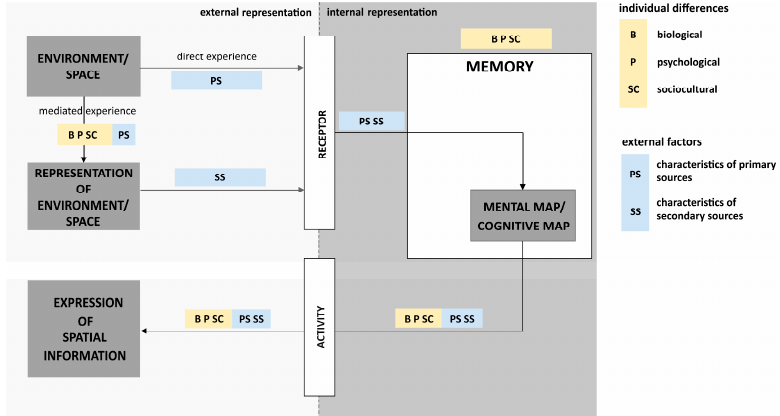
Figure 1. The process of spatial perception with a group of factors (Source: modified from [2,28,29]).